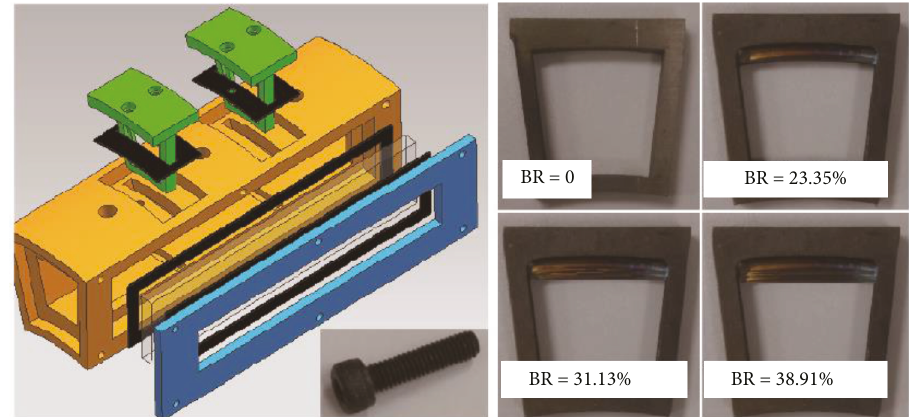
Figure 5: Illustration of a novel spoiler installation method in a channel of the WRC and spoilers with di ff erent blockage